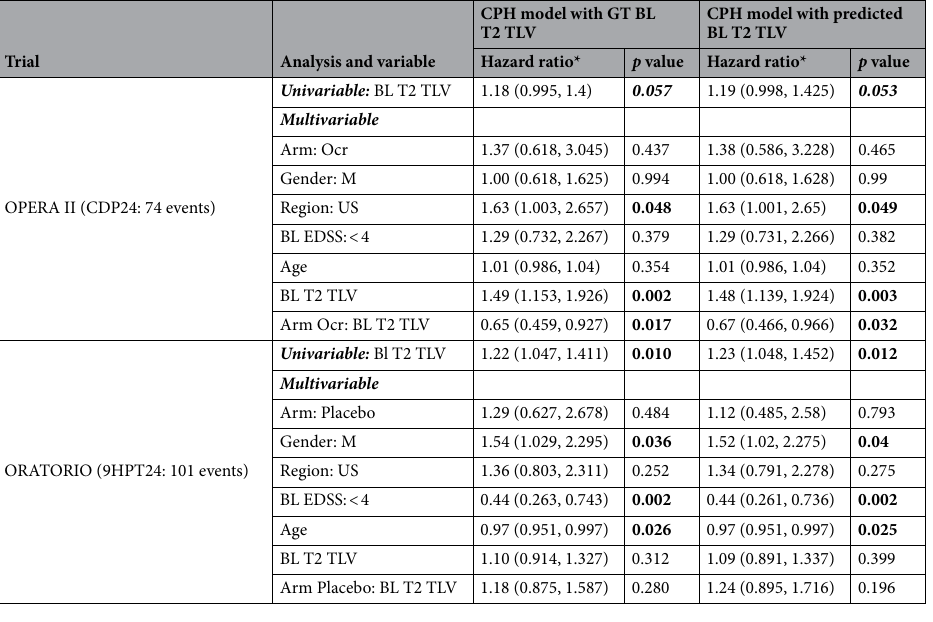
Table 4. Association of baseline T2 TLV with confirmed disability progression sustained for 24 weeks in the OPERA II and ORATORIO trials. Significant values are in bold and bolditalics. Region: US versus rest of world; BL EDSS: < 4 versus ≥ 4; log-transformed TLV was used in the CPH models. *Numbers in parenthesis are 95% confidence